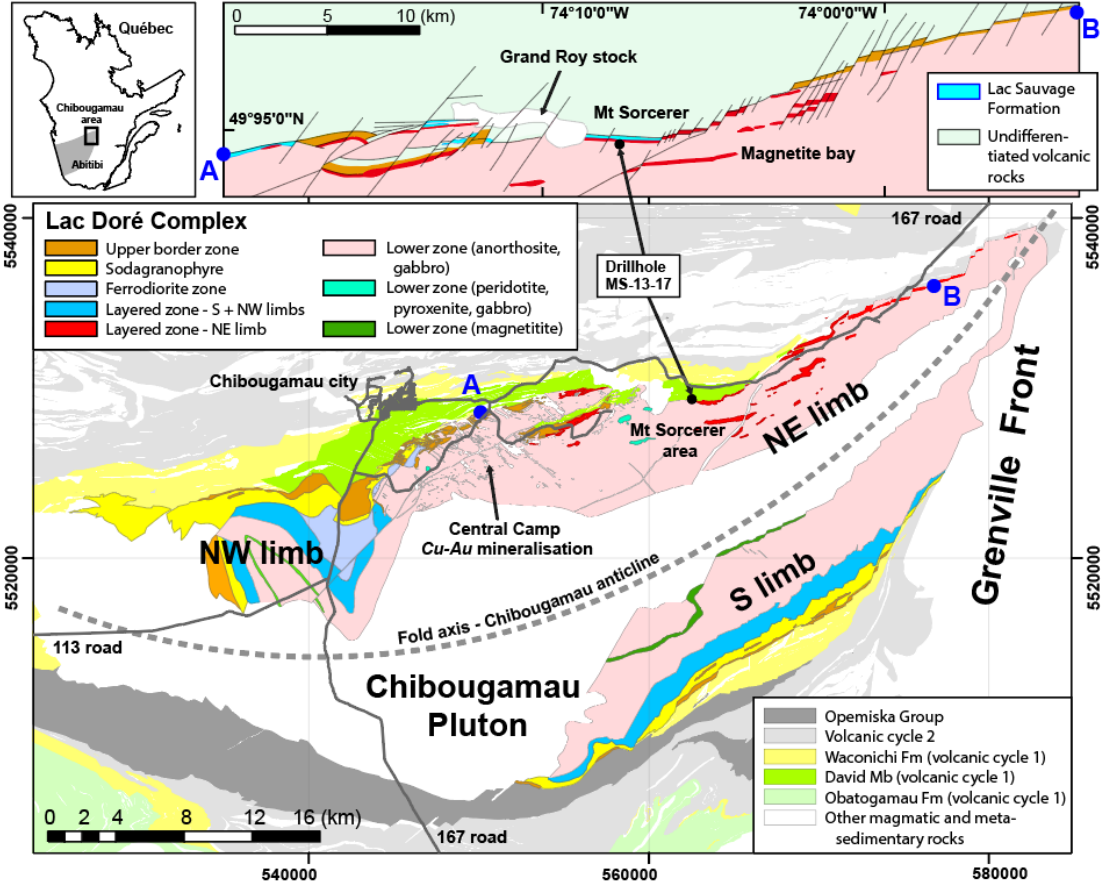
Figure 1. Geological map of the Lac Doré Complex (LDC) from the Ministère de l’Énergie et des Ressources Naturelles (MERN), Québec (système d'information géominière du Québec—SIGEOM; http://sigeom.mines.gouv.qc.ca). The geographic projection is UTM (NAD83, zone 18U). The zoomed map (top of the figure) is adapted from the map of Lapallo [5], and the geographic projection uses WGS84.